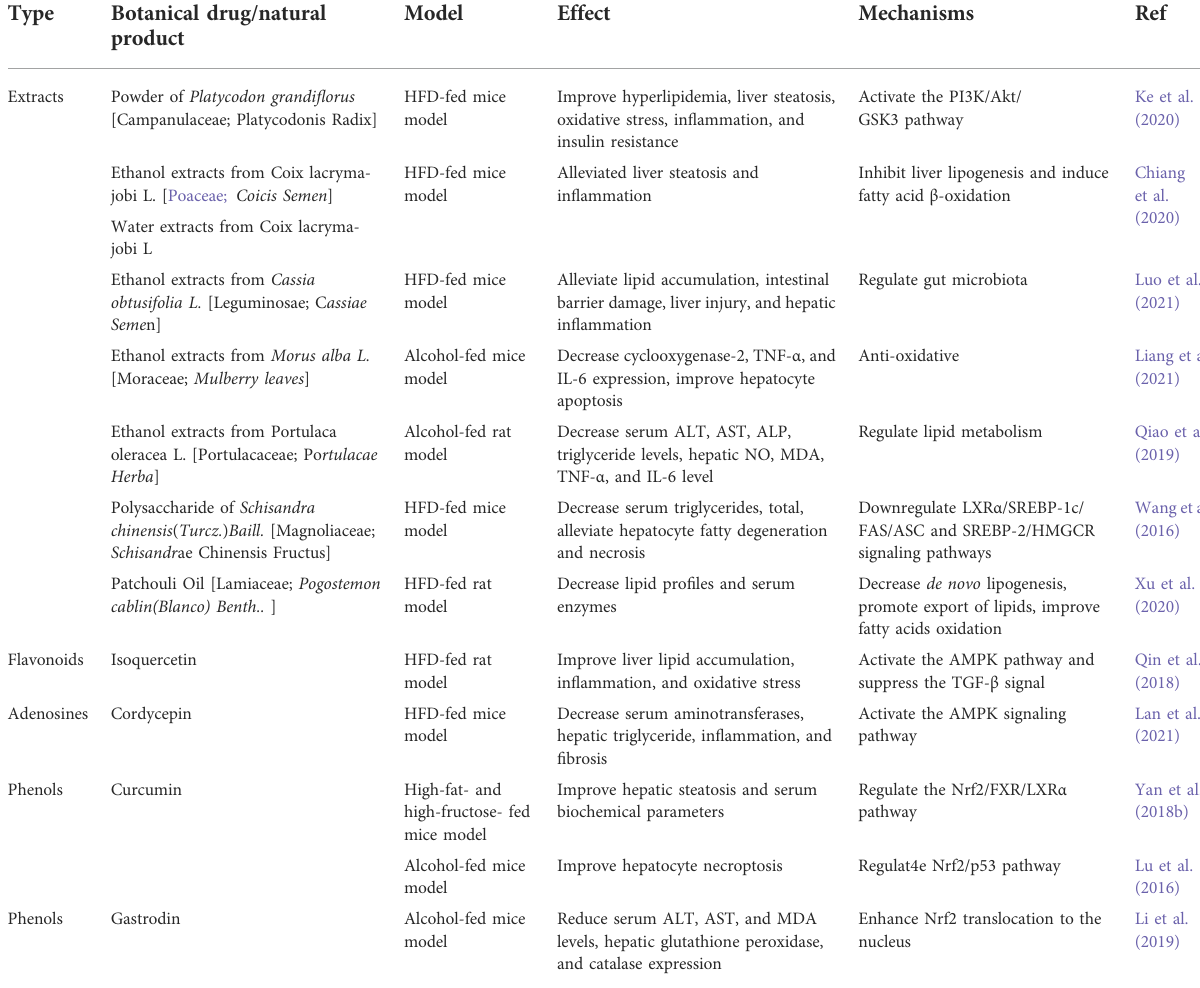
TABLE 2 Therapeutic effects of Botanical drugs and natural products on